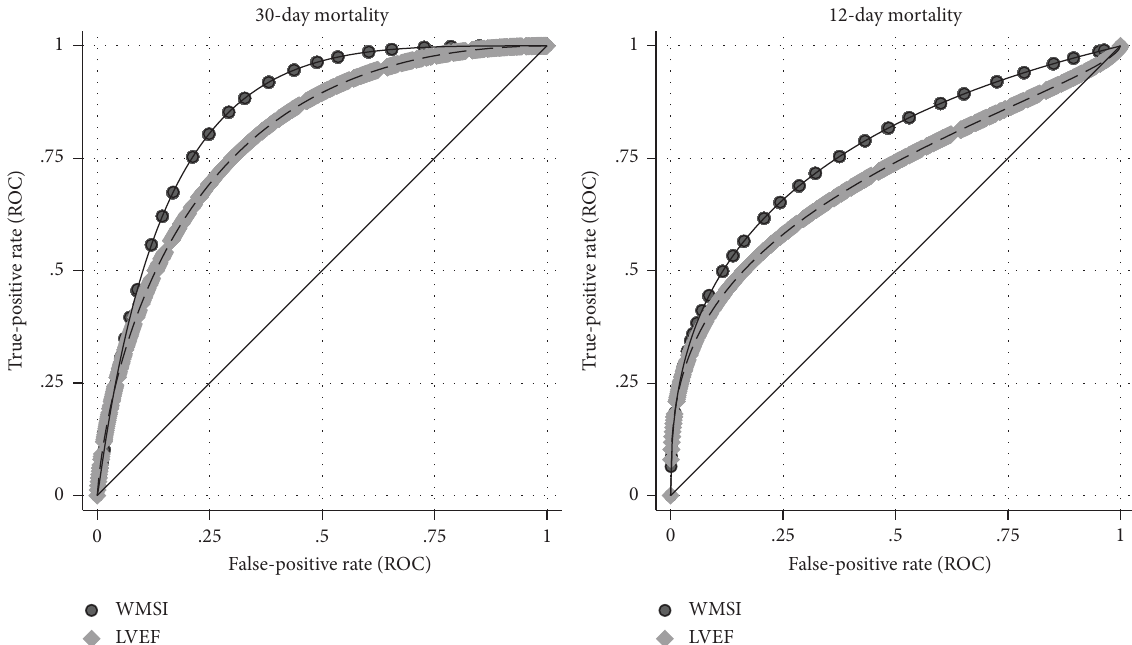
Figure 3: Comparison of receiver operator curves for 30-day and 12-month all-cause mortality by WMSI and LVEF demonstrating higher AUC for WMSI compared to LVEF. WMSI–Wall motion score index, LVEF–Left ventricular ejection fraction.